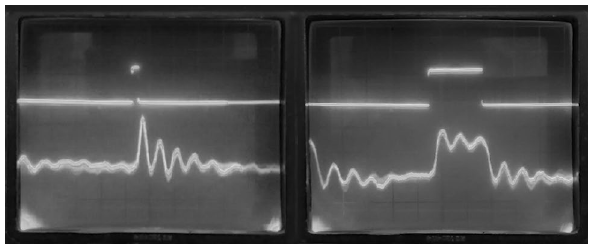
Figure 5. Left waveforms show a system response on the repetitive acoustic pulse 1 ms long. Waveforms on the right correspond both to the pulse duration and repetition frequency increased. The damped oscillatory process is clearly visible, possibly because of an echo in the container. The upper beam shows a hydroacoustic radiator input signal, while the lower one is the op-amp output voltage. The electric power of the impulse applied to the hydroacoustic radiator is equal to 1 mJ. The polarization direction of the wave is deviated from the soundwave propagation vector by 45 ◦ . We were able to observe the effect confidently down to pulse energies of 1 µ J .